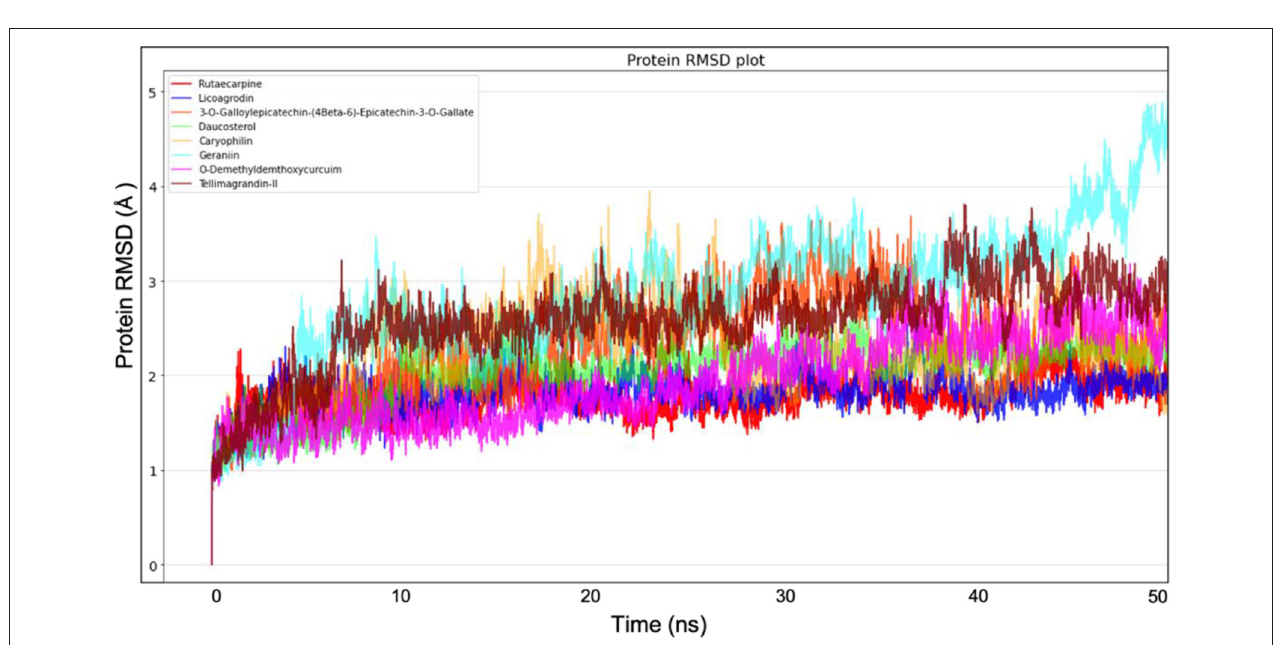
FIGURE 7 | Protein Backbone RMSD plots from Molecular dynamics for all the 8 top ranking protein-ligand complexes.